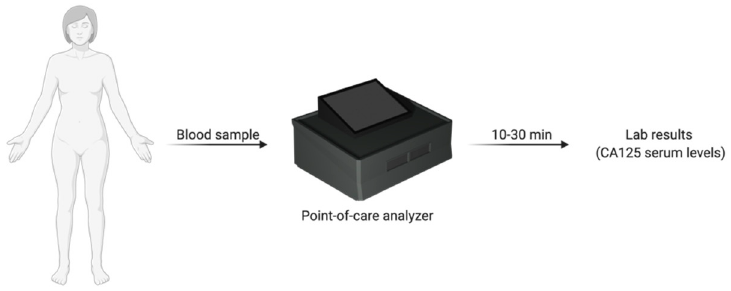
Figure 2. 5-year survival in stage IIIa/b and IIIc patients with optimal and suboptimal resection at primary cytoreductive surgery [26,174]. Figure 3. Point-of-care biomarker analyzer for primary care facilities.